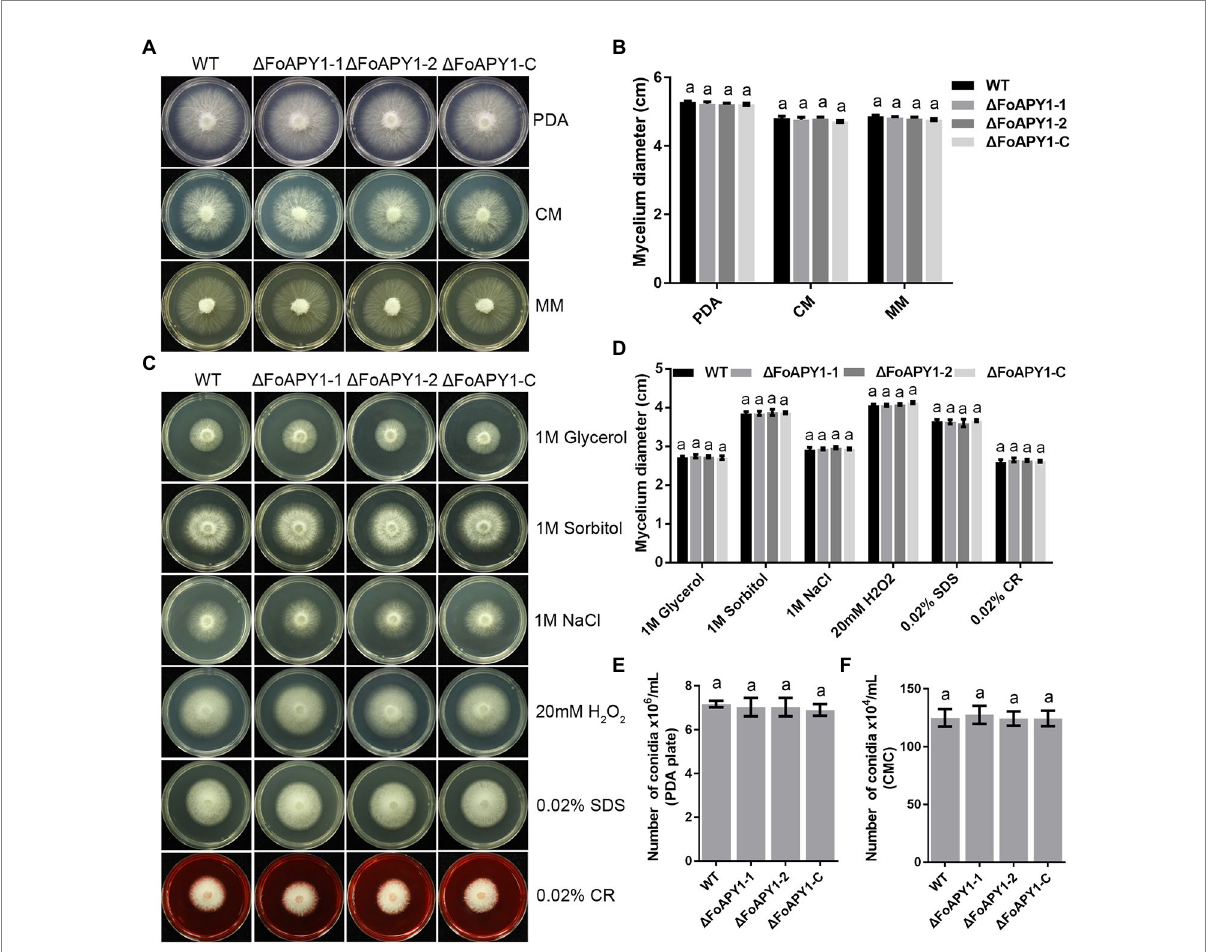
FIGURE 3 The FoAPY1 is not essential for mycelial growth or conidiation of F. oxysporum . (A) Mycelial growth of WT, two ∆ FoAPY1 mutant and ∆ FoAPY1-C complementation strains grown on PDA media, CM and MM at 25 ° C for 3 days in the dark. (B) Quantification of colony diameters for the WT strain, ∆ FoAPY1 mutant, and ∆ FoAPY1-C complementation strain cultured on PDA media, CM and MM after 3 days. (C) Mycelial growth of all strains on PDA media amended with 1 M glycerol, 1 M sorbitol, 1 M NaCl, 20 mM H 2 O 2 , 0.02% SDS, and 0.02% CR. All the strains were cultured at 25 ° C in the dark, and images were taken after incubation for 3 days. (D) Quantification of colony diameters for all targeted strains growing from the mycelial plug on PDA media with the different stress-mimicking agents. (E) The number of conidia of the WT, Δ FoAPY1 mutant and ∆ FoAPY1-C complementation strains was measured after 6 days of incubation on PDA media at 25 ° C. The conidia were harvested using ddH 2 O and then filtered through lens paper. (F) Conidia number of all the strains cultured in CMC liquid media at 180 rpm at 25 ° C for 2 days. All the experiments were performed three times in this study. The collected data were analyzed by one-way ANOVA for statistical tests. In the figures, the same letters on the bars mean no significant